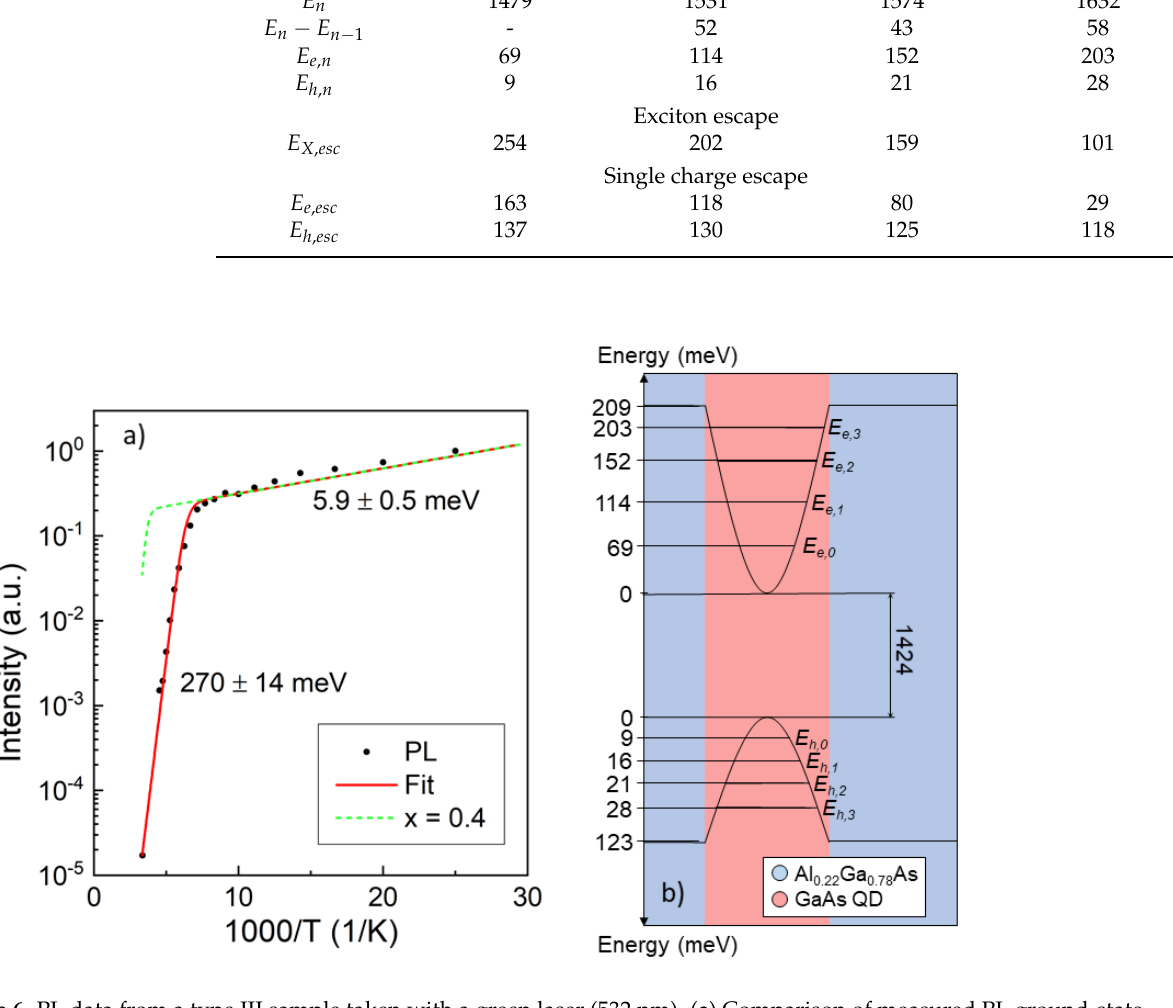
Figure 6. PL data from a type III sample taken with a green laser (532 nm). ( a ) Comparison of measured PL ground-state intensities at different temperatures (symbols) with model results (red line) using the indicated activation energies. The dashed green line is an estimation using the same model but for a higher Al content of 40%. ( b ) Diagram of conduction and valence band at the interface between Al 0.22 Ga 0.78 As barrier (blue) and GaAs QD (red). The QD energy levels and the band-gap energies at T R are indicated; all the energy values are in